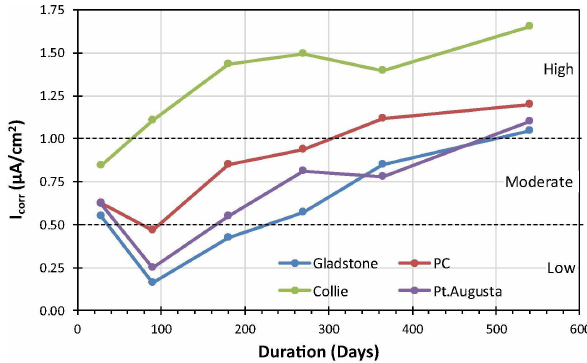
Figure 14: Corrosion rate of geopolymer and PC concrete specimens, immersed in 3% NaCl solution